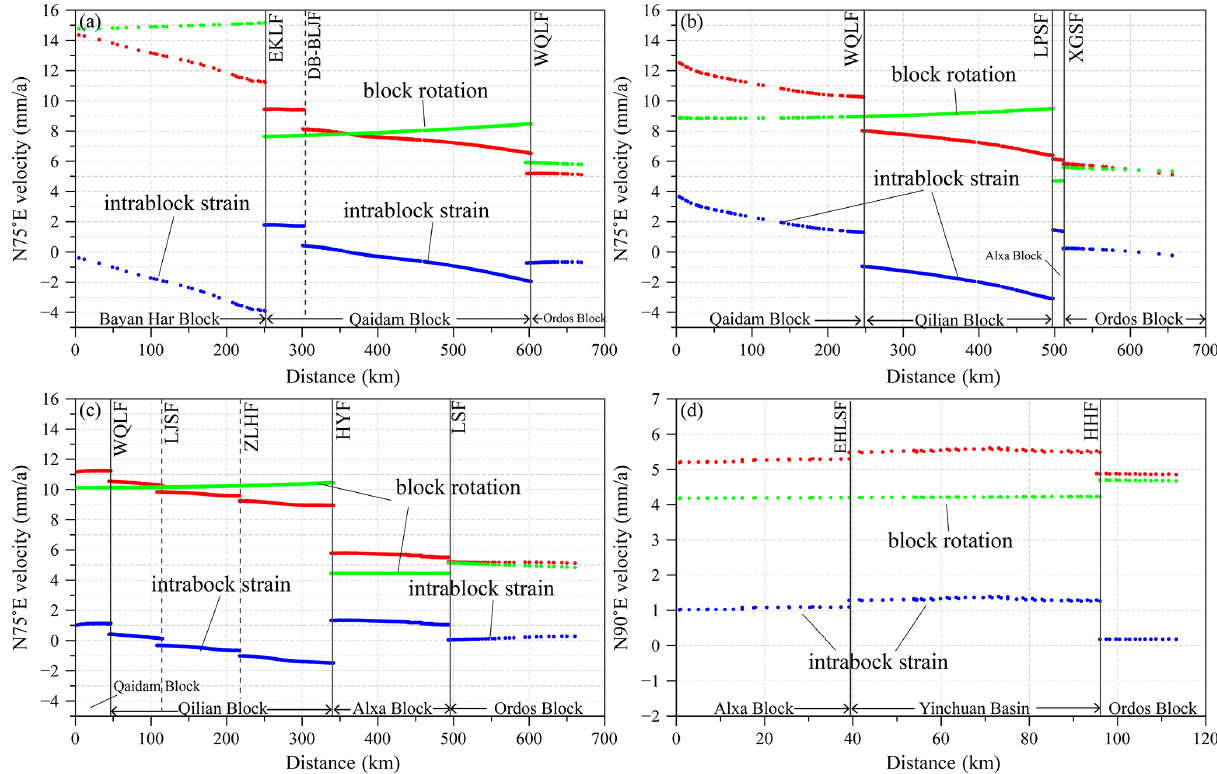
Figure 14. Modeled velocity profiles across the study area with profile orientation. The profiles in (a) – (d) correspond to A–A (cid:48) , B–B (cid:48) , C–C (cid:48) , and D–D (cid:48) in Fig. 11, respectively. The red dots indicate the components along the profiles of the node motion velocity within 2km on both sides of the profile. The green dots represent the velocity component along the profiles due to plate rotation. The blue dots indicate the differences between the red and green dots. Fault names are defined in Fig.